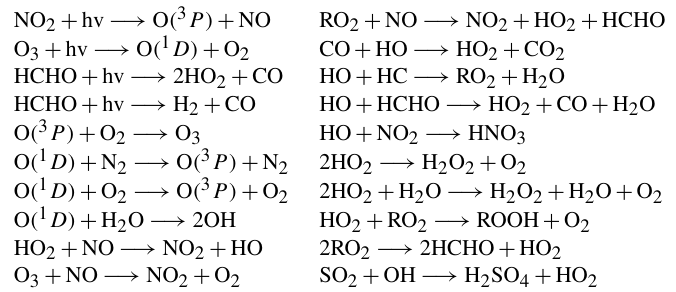
Table A1. List of chemical reactions included as gas-phase chemistry mechanism in M2UE model.